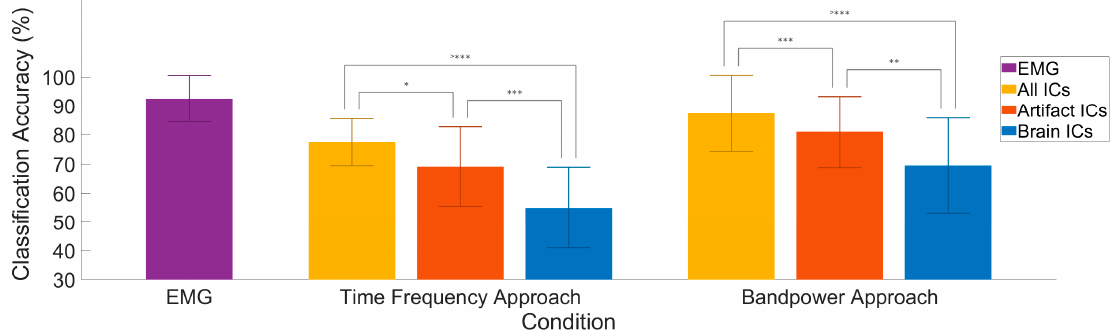
Figure 7. Comparison of classifier conditions. Group averaged classification accuracy is displayed for each of the separate conditions in a 5-class all-vs-one classification. ‘Brain’ and ‘Artifact’ consisted of 10 ICs across 10 bins of time, in 5 frequency bands, with dimensionality reduction to 70 features. ‘All ICs’ was calculated by the same procedure, only with all ICs available. ‘EMG’ used 7 channels on the side of movement, binned into 10 time bins each for features. Significance levels: * < 0.05, ** < 0.01, *** < 0.001.